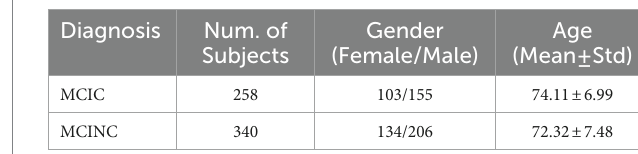
TABLE 1 Demographics information of the obtained subjects.